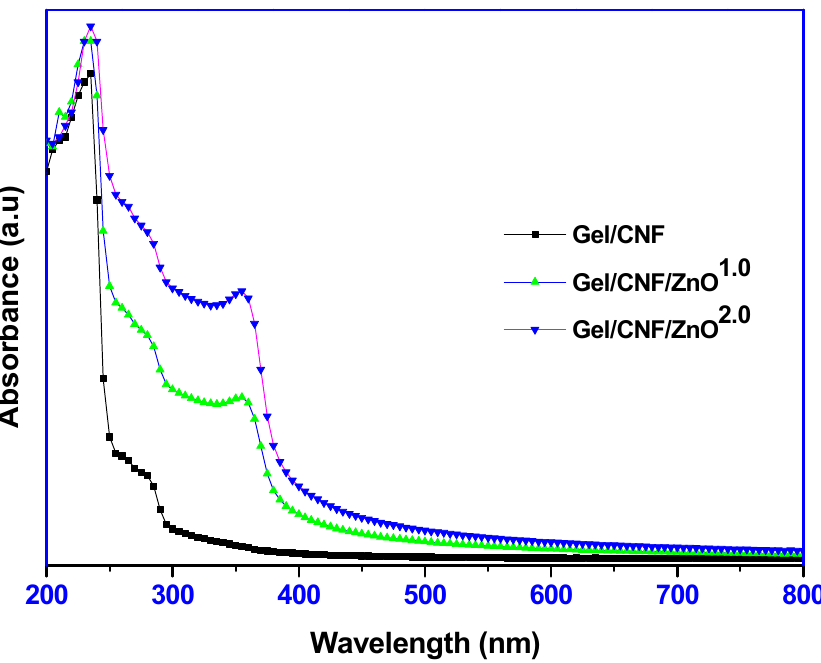
Figure 2. UV ‐ vis absorption profile of the gelatin/CNF ‐ based films. Figure 2. UV-vis absorption profile of the gelatin/CNF-based